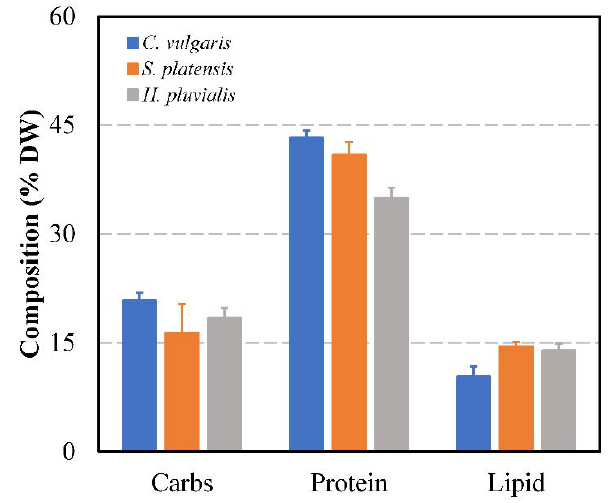
Figure 1. Biochemical compositions of cultivated microalgae.